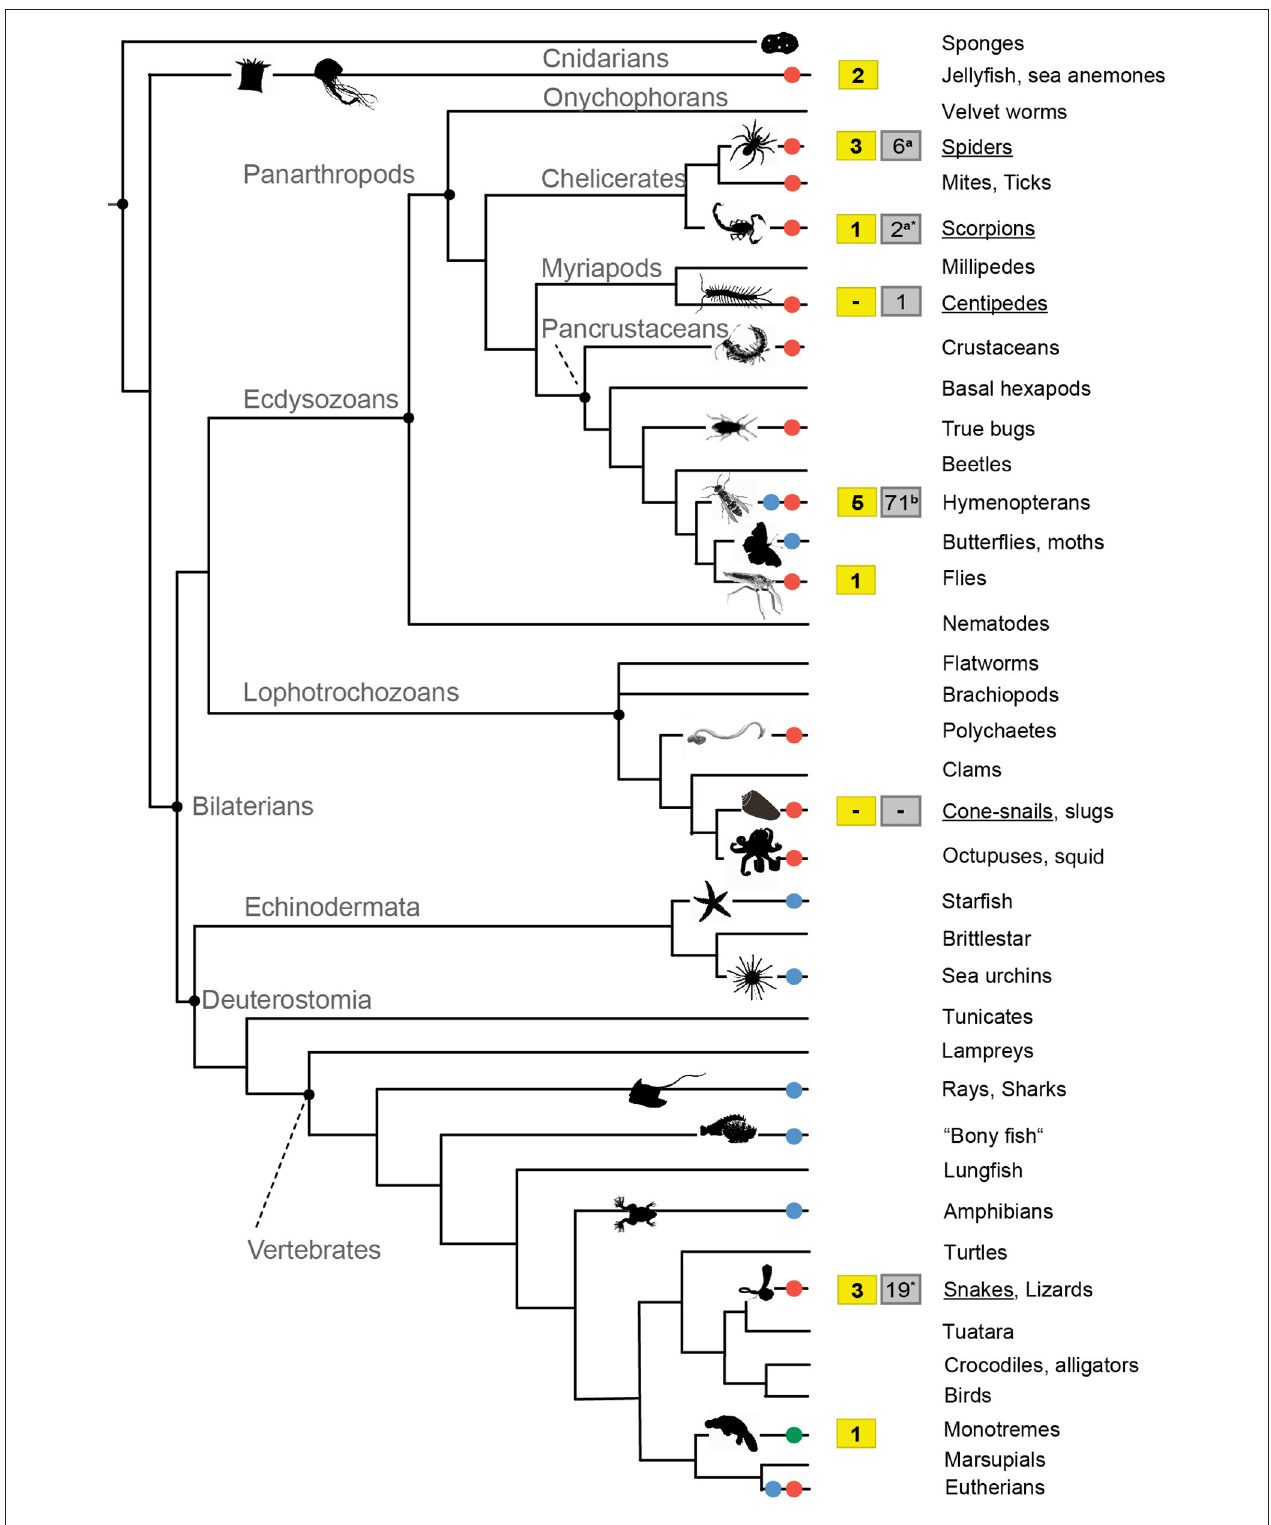
FIGURE 1 | Simplified phylogenetic tree that displays the evolution of venom in the animal kingdom and data availability of “whole genome-venom” studies. Taxa that employ venoms for predation are marked by red dots, for defense by blue dots and for competition in green dots. Available genome data for taxa that were used in